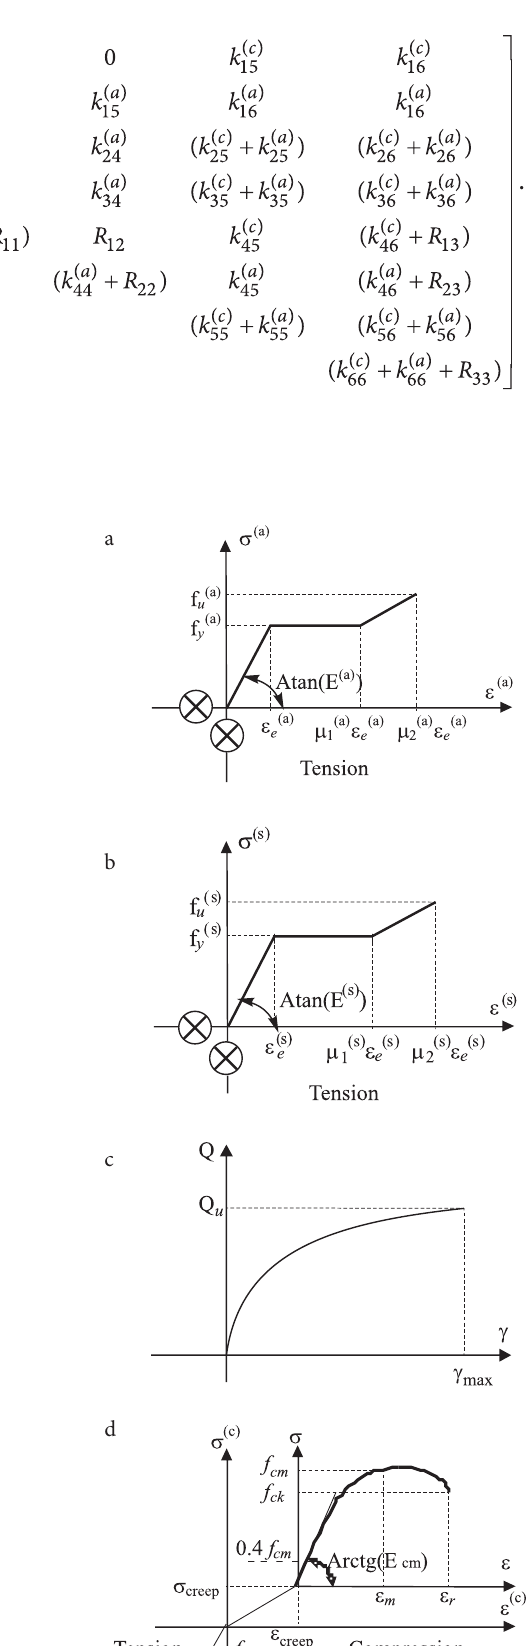
Fig. 4. Steel girder behaviour (a); reinforcing steel behaviour (b); ductile stud behaviour (c); concrete behaviour with creep